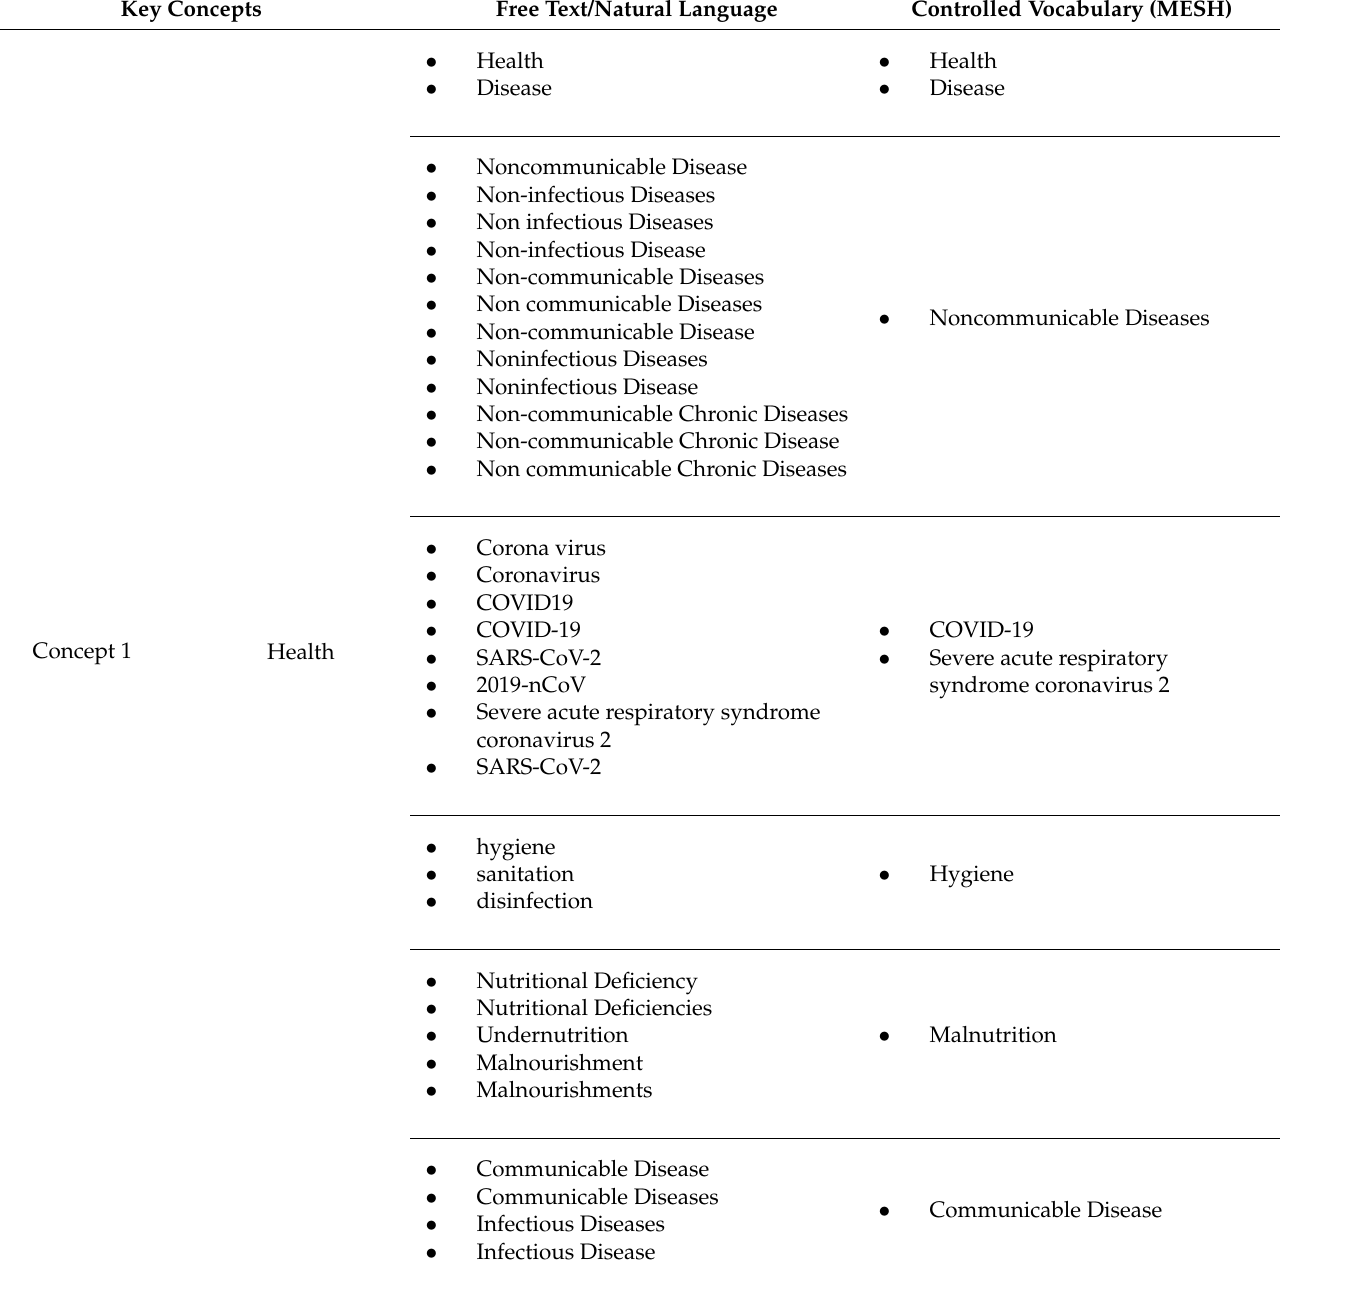
Table A1. Search strategy by key